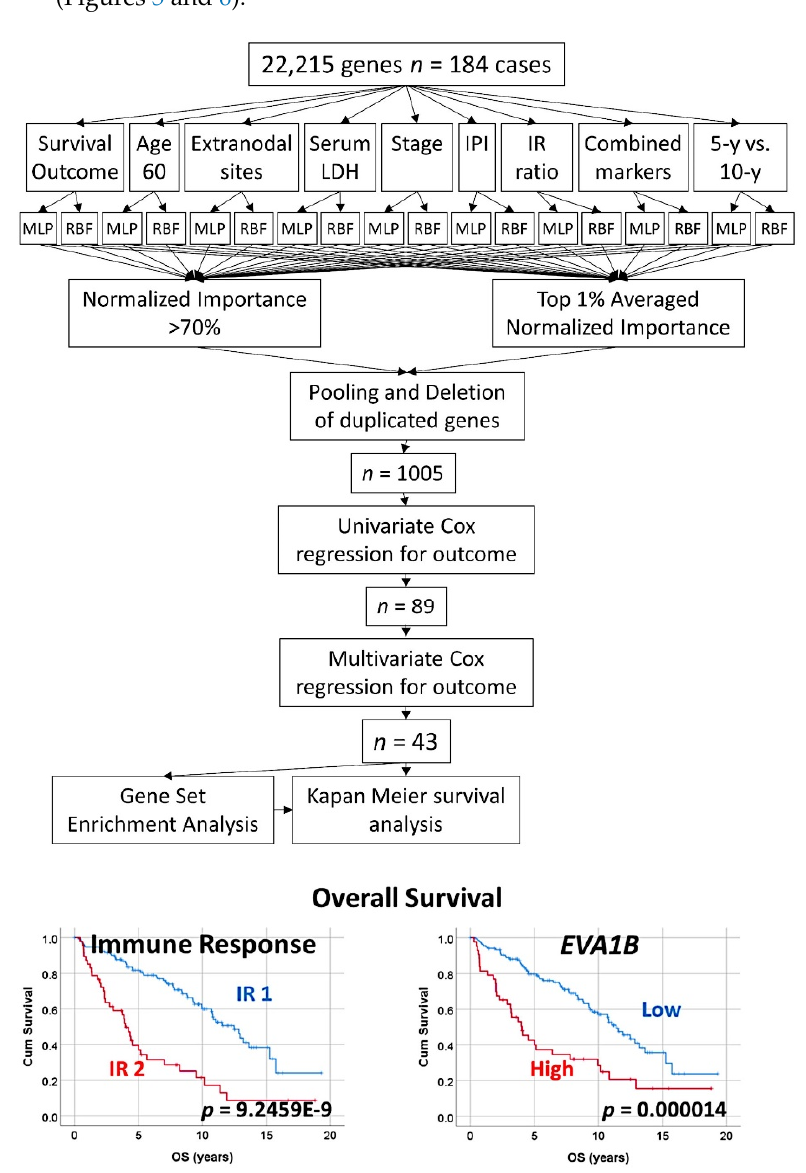
Figure 5. Prediction of the overall survival of follicular lymphoma using an algorithm based on neural networks. The algorithm combined multilayer perceptron (MLP), radial basis function (RBF), and COX regression to highlight 43 genes with prognostic relevance; finally, a correlation with immuno-oncology genes was also performed. This figure shows the algorithm (method) that was used to analyze the gene expression data of follicular lymphoma using artificial neural networks. From an initial set of 22,215 genes, a strategy of dimensionality reduction highlighted 43 genes, of which 18 were associated with poor and 25 with good overall survival of the patients. The first